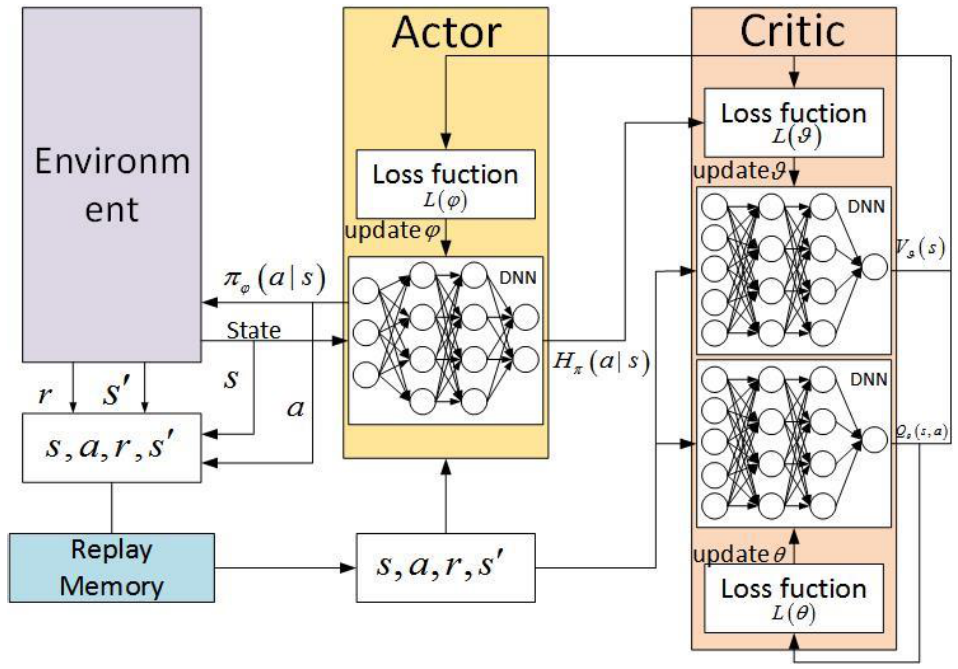
Figure 9. The structure of the soft-ACDRL algorithm.